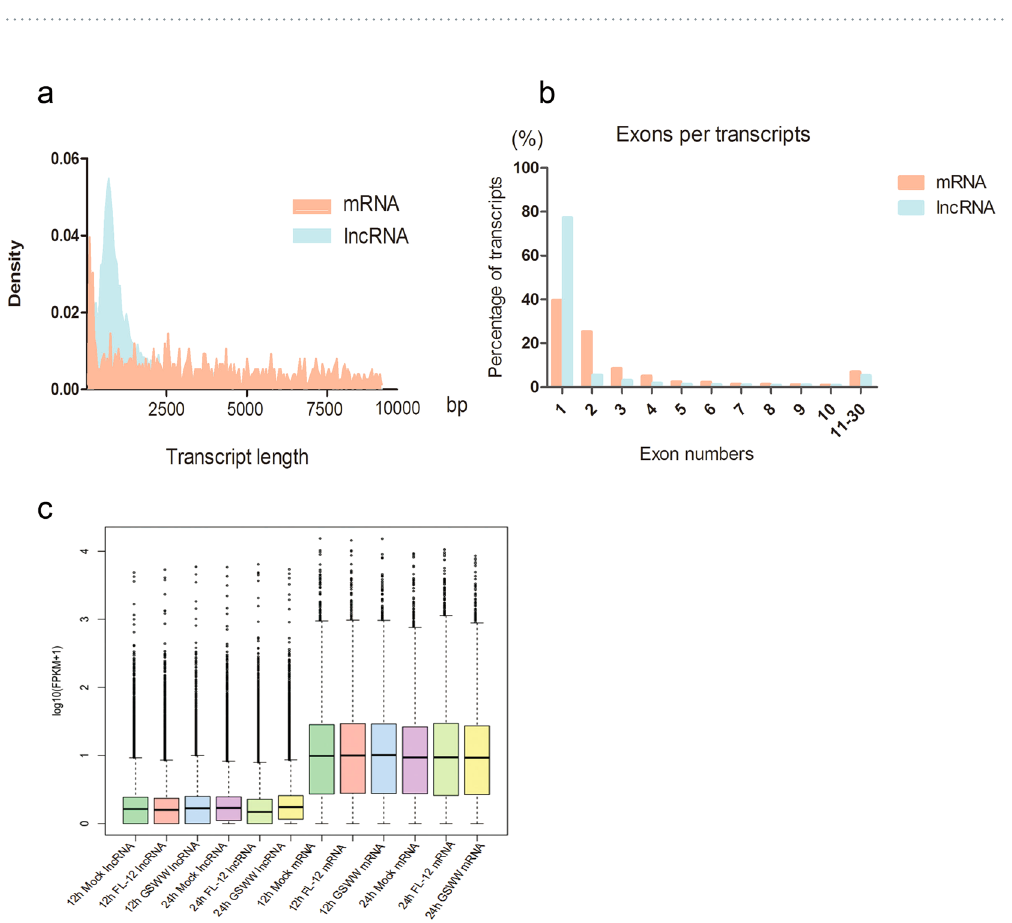
Figure 3. Genomic features of mRNAs and predicted lncRNAs. ( a ) Density map of length distribution of mRNAs and novel lncRNAs identified in RNA-Seq. ( b ) Exon number distributions of mRNAs and predicted lncRNAs in RNA-sequencing. ( c ) Boxplots demonstrating (showing minimum, 25%, 50%, 75% and maximum) the expression features of mRNAs and lncRNAs in each